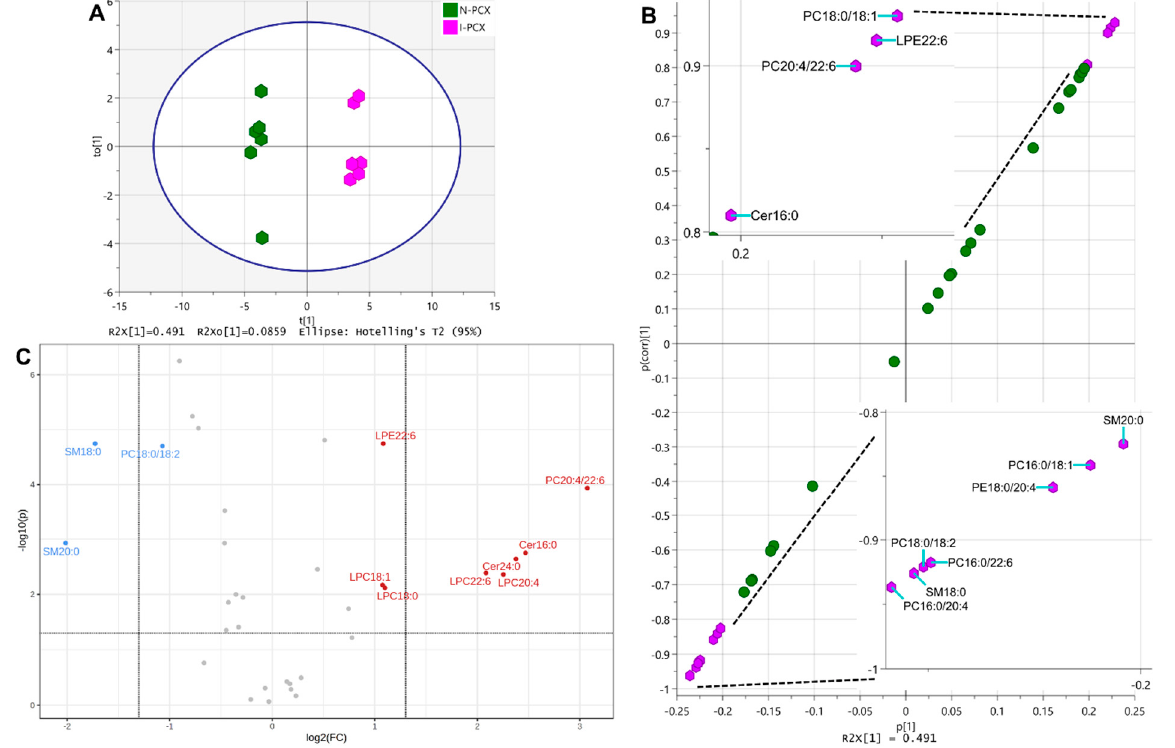
Figure 5. ( A ): The scatter plot of OPLS-DA on lipids in normal parietal cortex (N-PCX) and ischemic parietal cortex (I-PCX) of rat brains. ( B ): S-plot of OPLS-DA on lipids in N-PCX and I-PCX of rat brains. Lipid species with p(corr)[1] > 0.8 (upper-right purple hexagons and upper-left inset) or < − 0.8 (lower-left purple hexagons and lower-right inset) are identified. ( C ): Volcano plot analysis on lipids in N-PCX and I-PCX of rat brains. Lipids with − log10(p) > 1.301 and log2(FC) > 1 or < − 1 are identified. See Figure 3 legend and text for details.